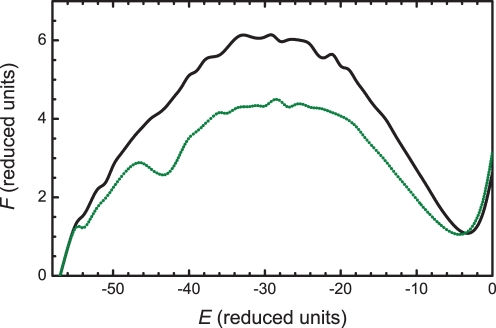
Examples of the free energy profiles F obtained for two of the circular permutants in family H.See text for details.